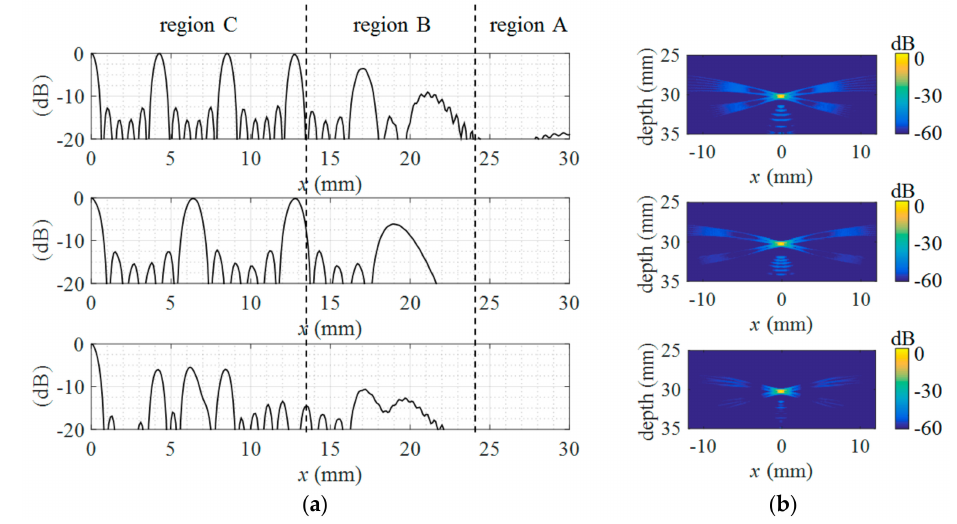
Figure 5. ( a ) Simulated Tx beam patterns and ( b ) 2D PSFs of round-trip focusing using the PW angle sets shown in Figure 3a–c (from top to bottom